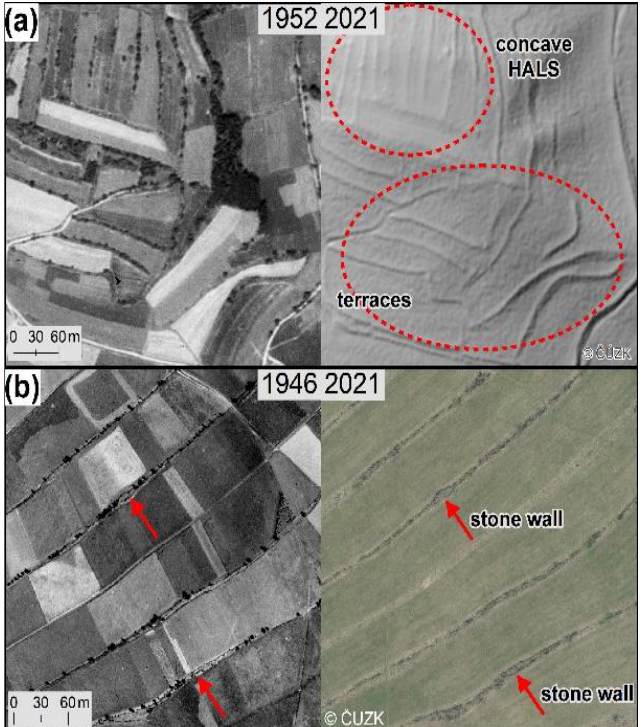
Figure 5. HALs captured in black and white archival aerial imagery: ( a ) Vlksice site (Vlašim region) with landforms concave HALS and array of terraces noticeable in 1952 (left) and in present-day digital elevation model (right) ; ( b ) site of the former village of Mohelnice (Krušné Hory Mts) in 1946 and in 2020 with visible stone walls (indicated by red arrows) [data sources: Orthophoto of the CR, ČÚZK, Praha, Czech Republic; ZABAGED® — Altimetry —DMR 5G, ČÚZK, Pra ha, Czech Republic, imagery provided by the CMD, Czech Environmental Information Agency, ČÚZK, Praha, Czech Republic; processed in ArcGIS, ESRI, Redlands, CA, USA].